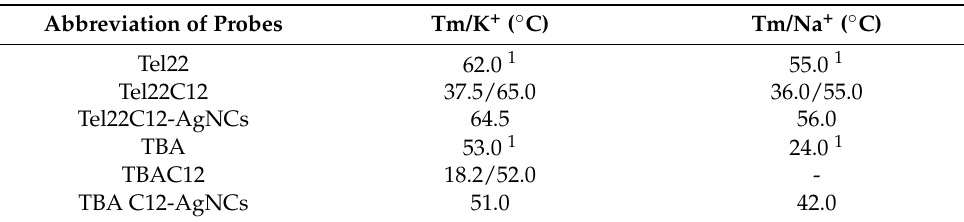
Table 2. Melting temperatures (T m ) of G-quadruplex-forming oligonucleotide probes determined from the melting profiles monitored at 295 nm in the presence of K + and Na +